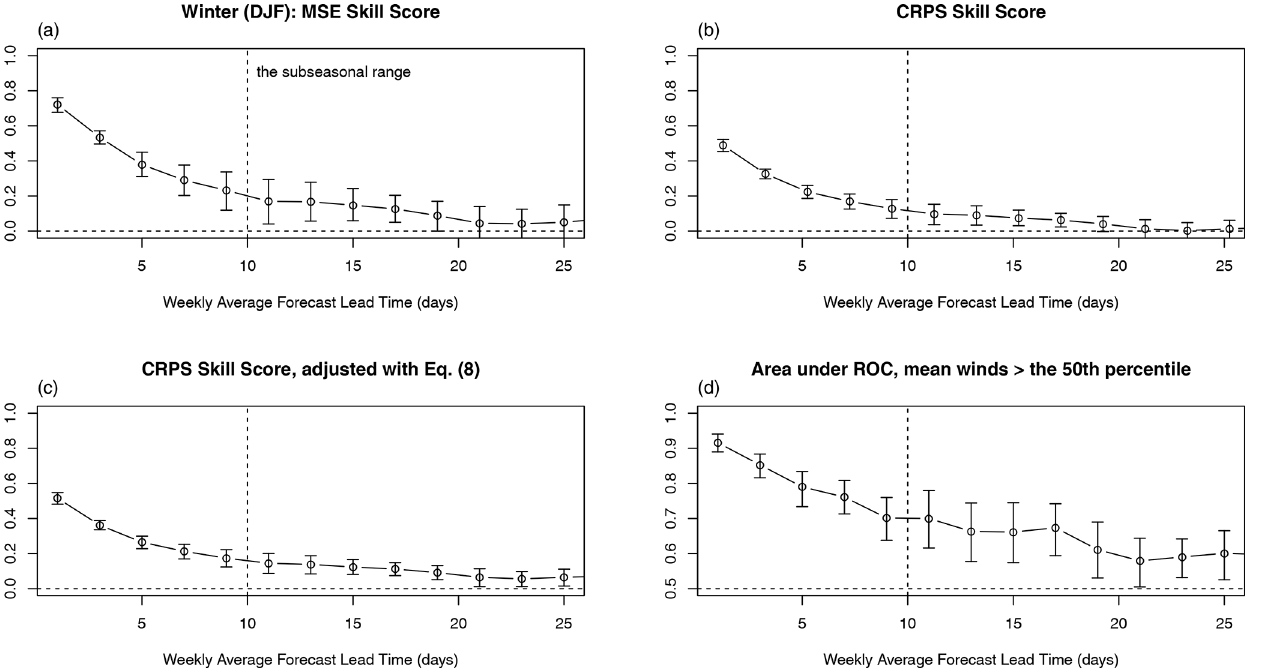
Figure 4. The verification measures of reforecasts (using the validation set, even winters 1996–2016) for the averaged area (Fig. 1). Re- forecasts are the mean of one week of 6-hourly reforecasts and start every two days. The skill score for (a) the MSE, (b) the CRPS without adjustment, (c) the CRPS adjusted with Eq. (8). (d) The area under ROC for the forecasts of mean winds greater than the 50th